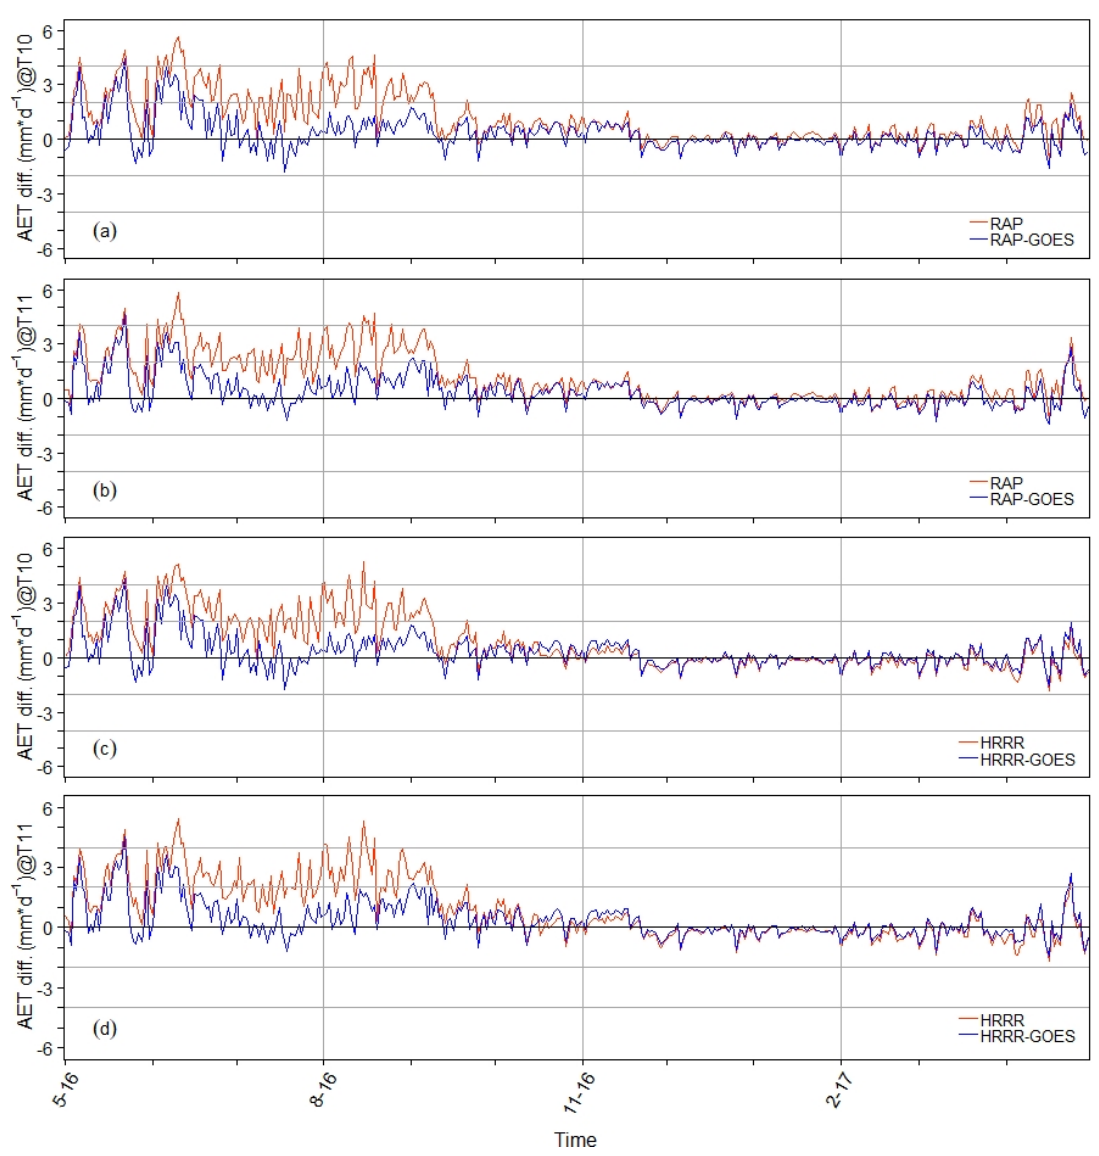
Figure 7. AET difference (modeled AET–observed AET) in mm d -1 at Tower 10 (T10, (a) and (c)) and Figure 7. AET di ff erence (modeled AET–observed AET) in mm d − 1 at Tower 10 (T10, ( a ) and ( c )) and Tower 11 (T11, (b) and (d)) between May 2016 and April 2017. Tower 11 (T11, ( b ) and ( d )) between May 2016 and April